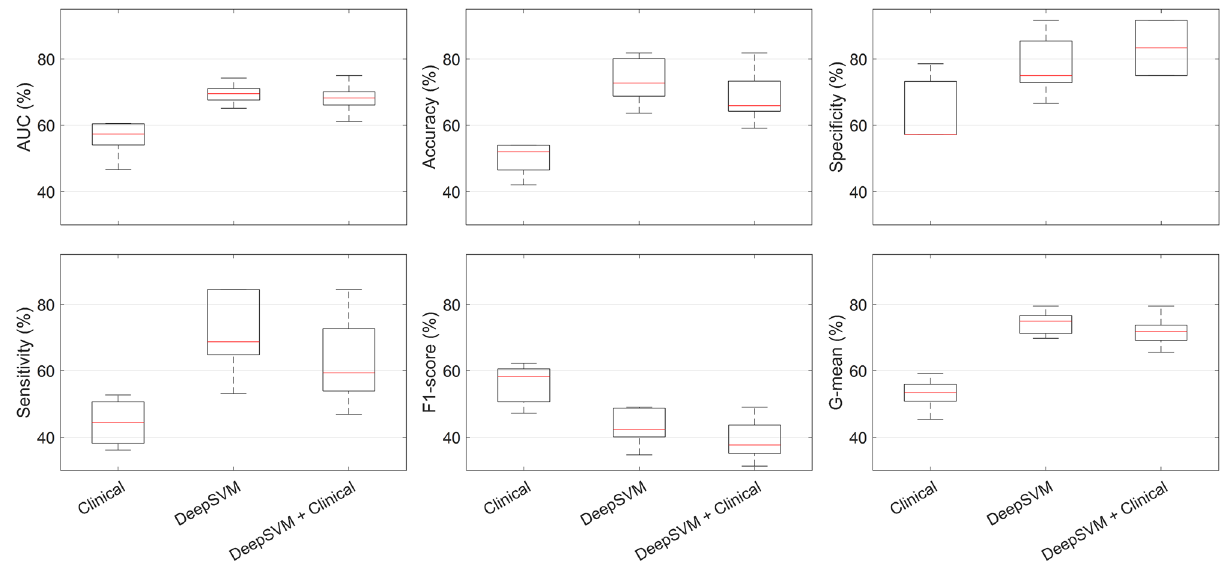
Figure 1. Boxplots of the performances of the 1-year disease-free survival predictive models in terms of percentage AUC, accuracy, sensitivity, specificity, F1-score and G-mean. The results are evaluated by implementing a fivefold cross validation scheme for five rounds on the CPTAC-CM public dataset.